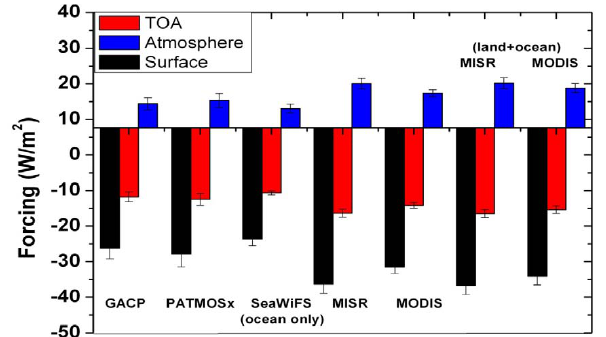
Fig. 5. Aerosol radiative forcing at the top, bottom and inside of the atmosphere computed from global mean aerosol optical depths derived from various satellite sensors and global mean aerosol optical properties estimated from 436 AERONET stations for a solar zenith angle of 40 ◦ and albedo of 5%.